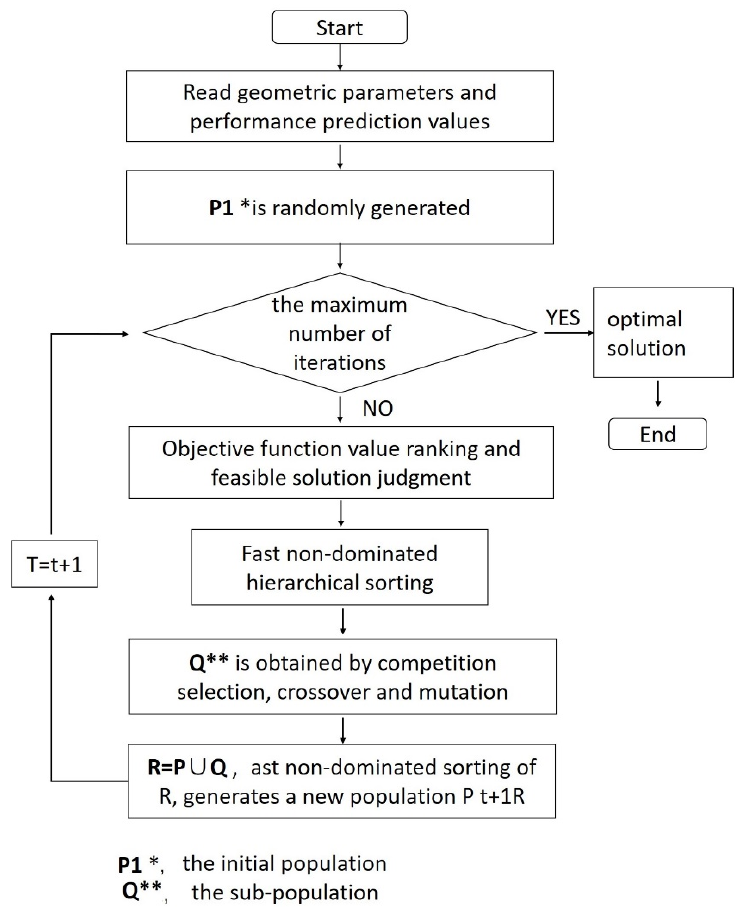
Figure 6. Block diagram for NSGA-II algorithm.